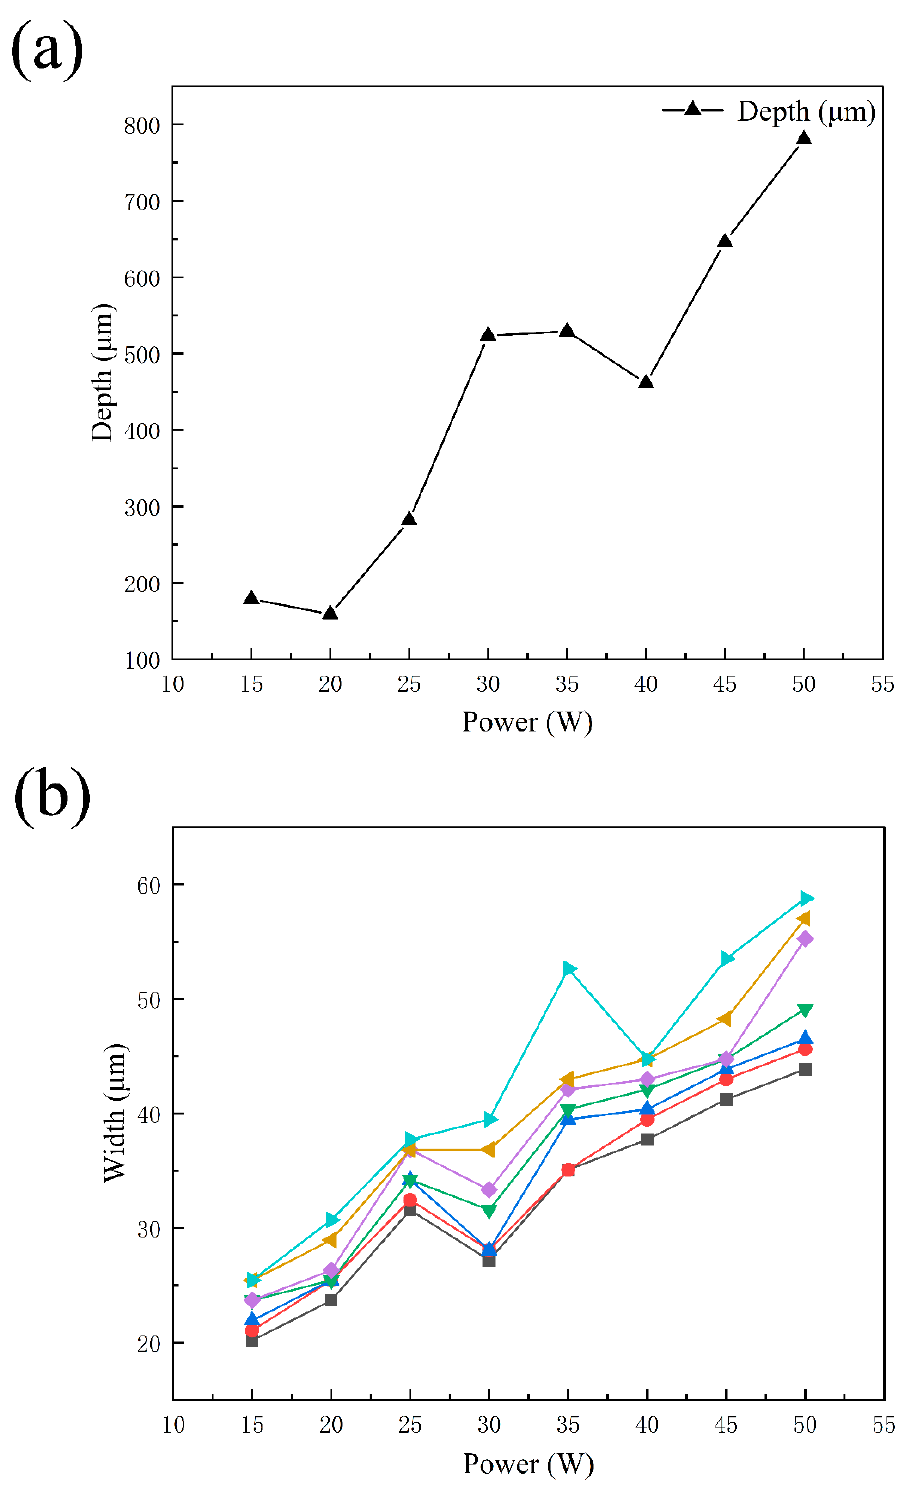
Figure 4. ( a ) Average penetration depth of intruded steel, ( b ) penetration width of laser scanning zone.